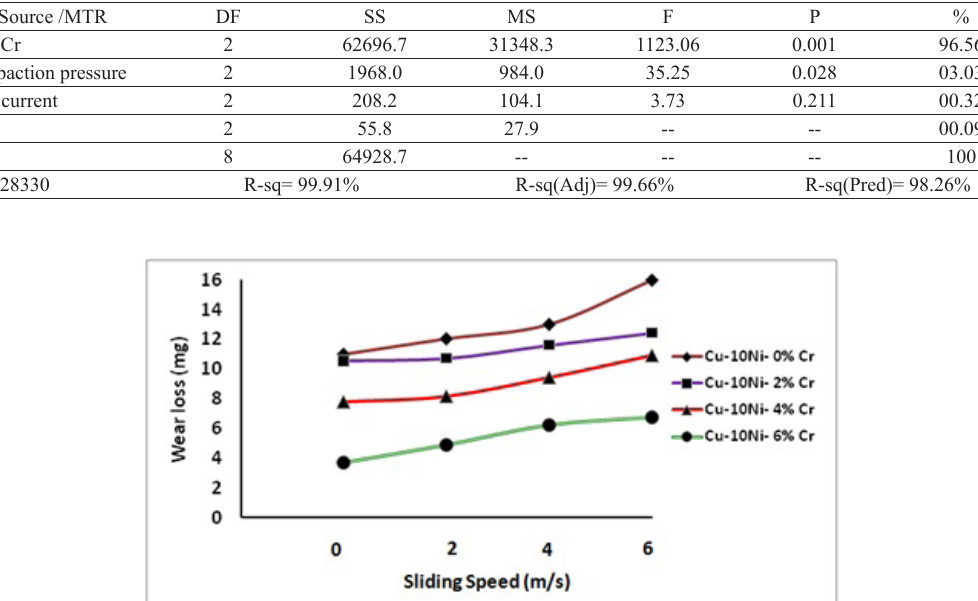
Table 5. Variance analysis for MTR.